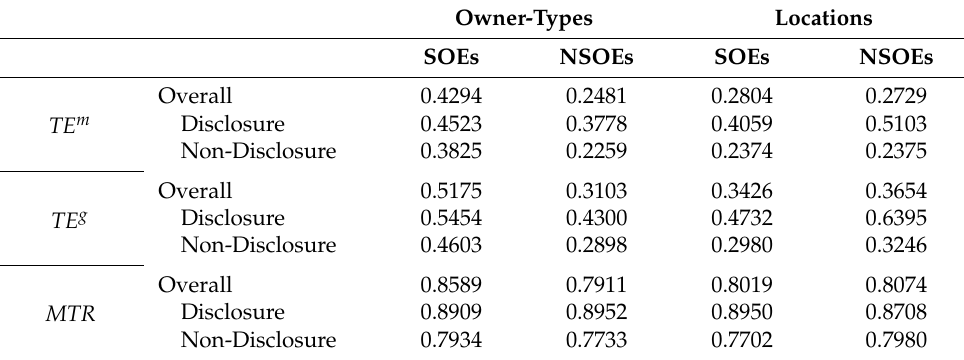
Table 5. Mean Values of TE m , TE g , and MTR by Owner-Types and/or Locations.